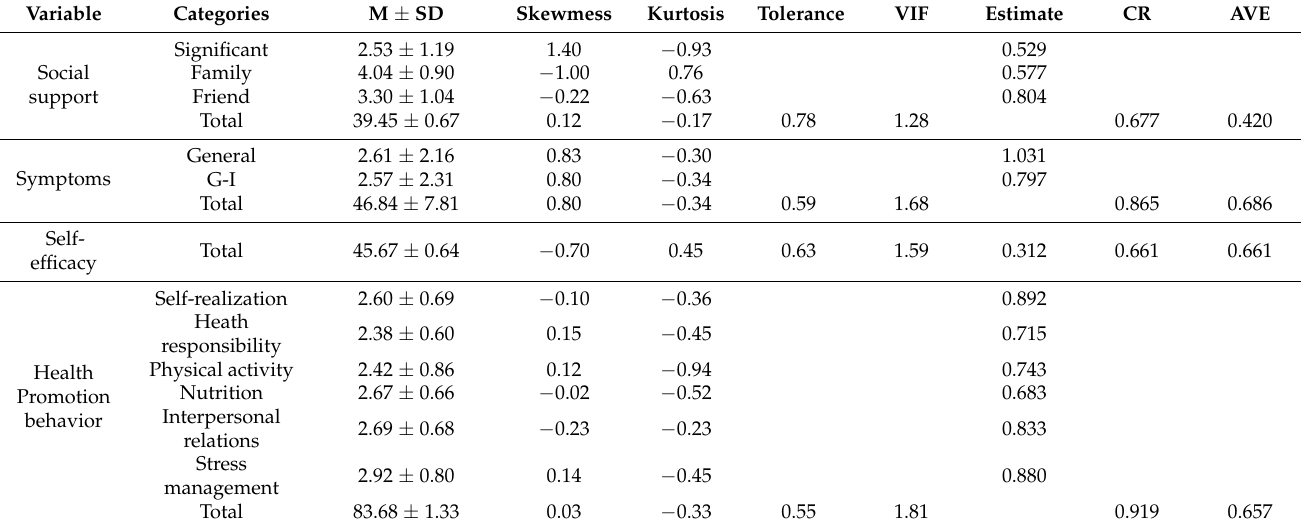
Table 2. Descriptive Statistics of